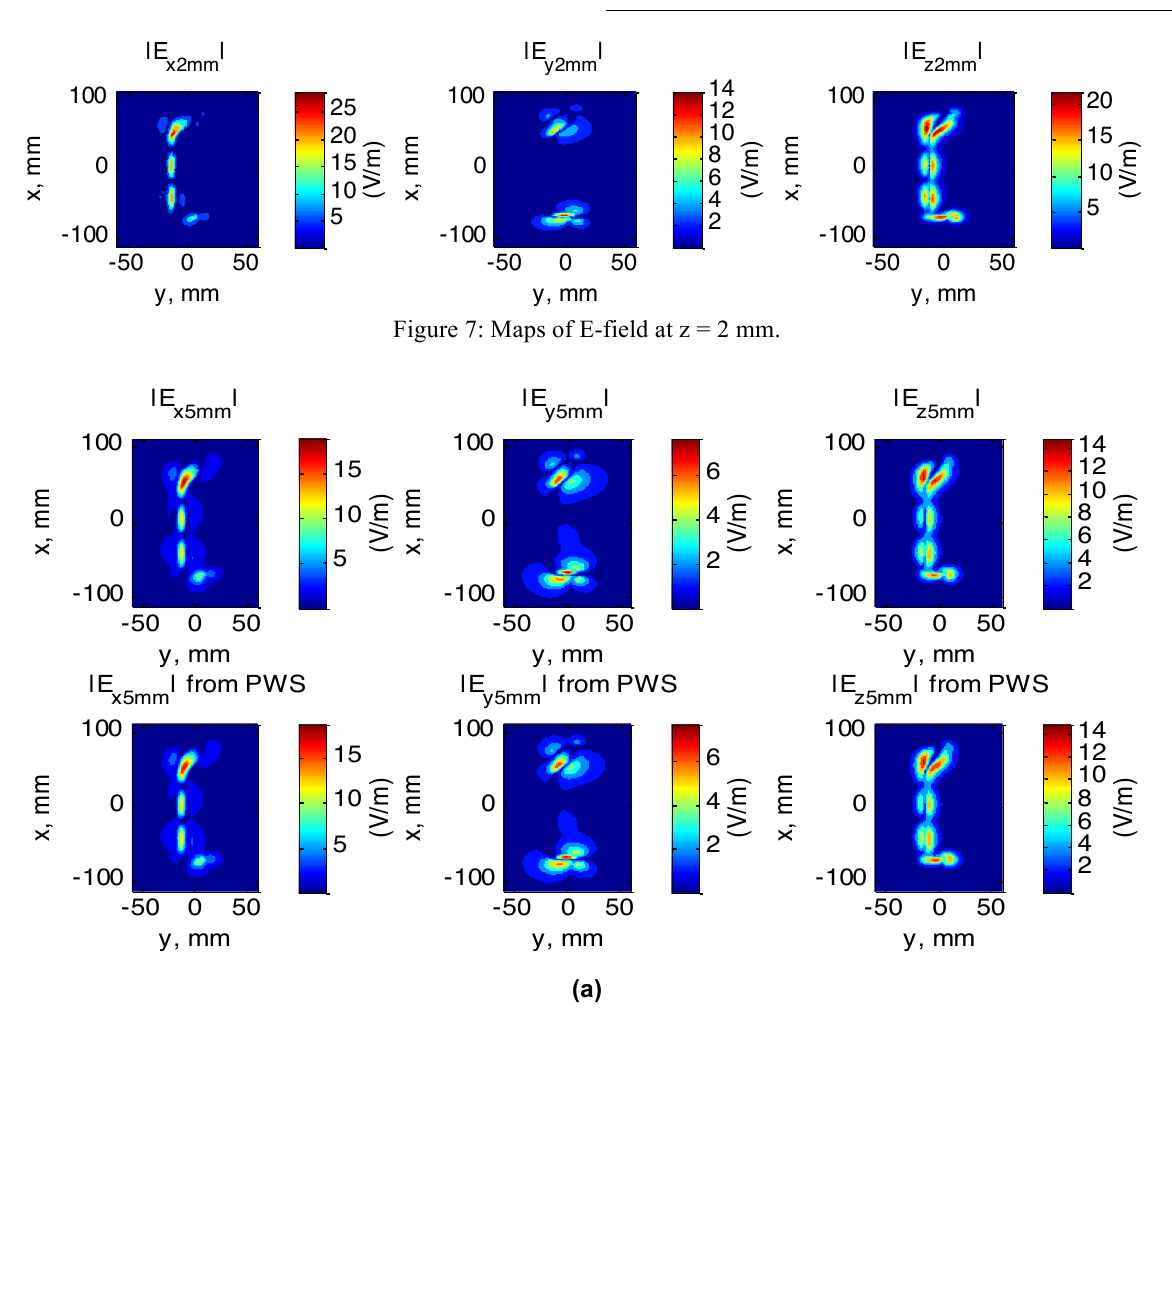
Figure 6: 3-D design of the planar microstrip structure simulated with HFSS.